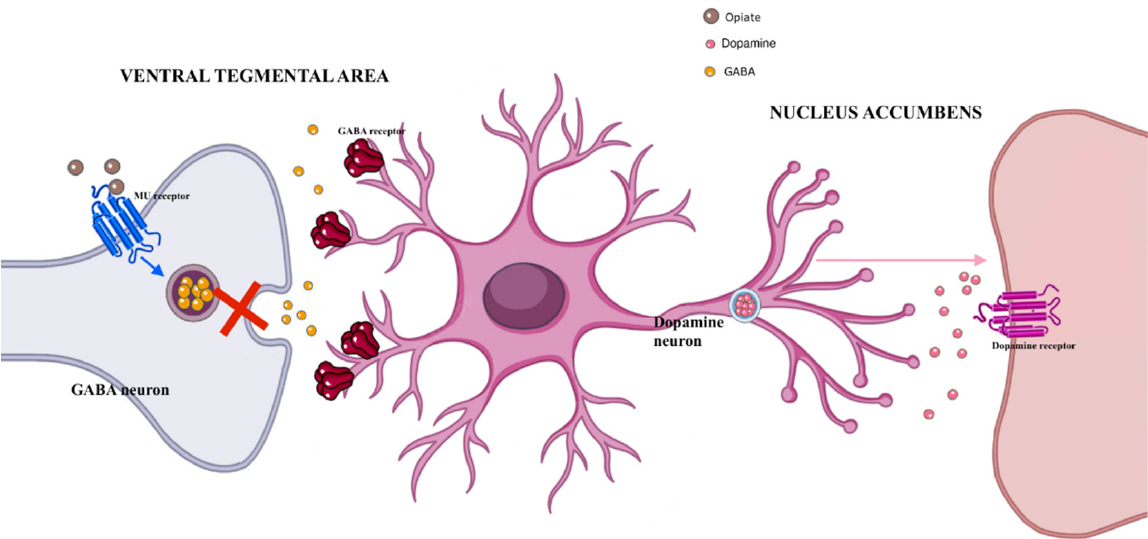
Figure 2. Molecular mechanisms associated with opioid effects. Abbreviations: GABA: gaba aminobu- tyric Figure 2 . Molecular mechanisms associated with opioid effects . Abbreviations: GABA: gaba ami- nobutyric acid.